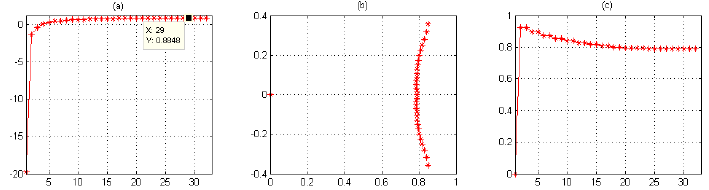
Figure 5. (a) the eigenvalues of the Jacobi (no damping) iteration matrix. (b) the eigenvalues of the (undamped) Gauss–Seidel iteration matrix, their absolute values are given in